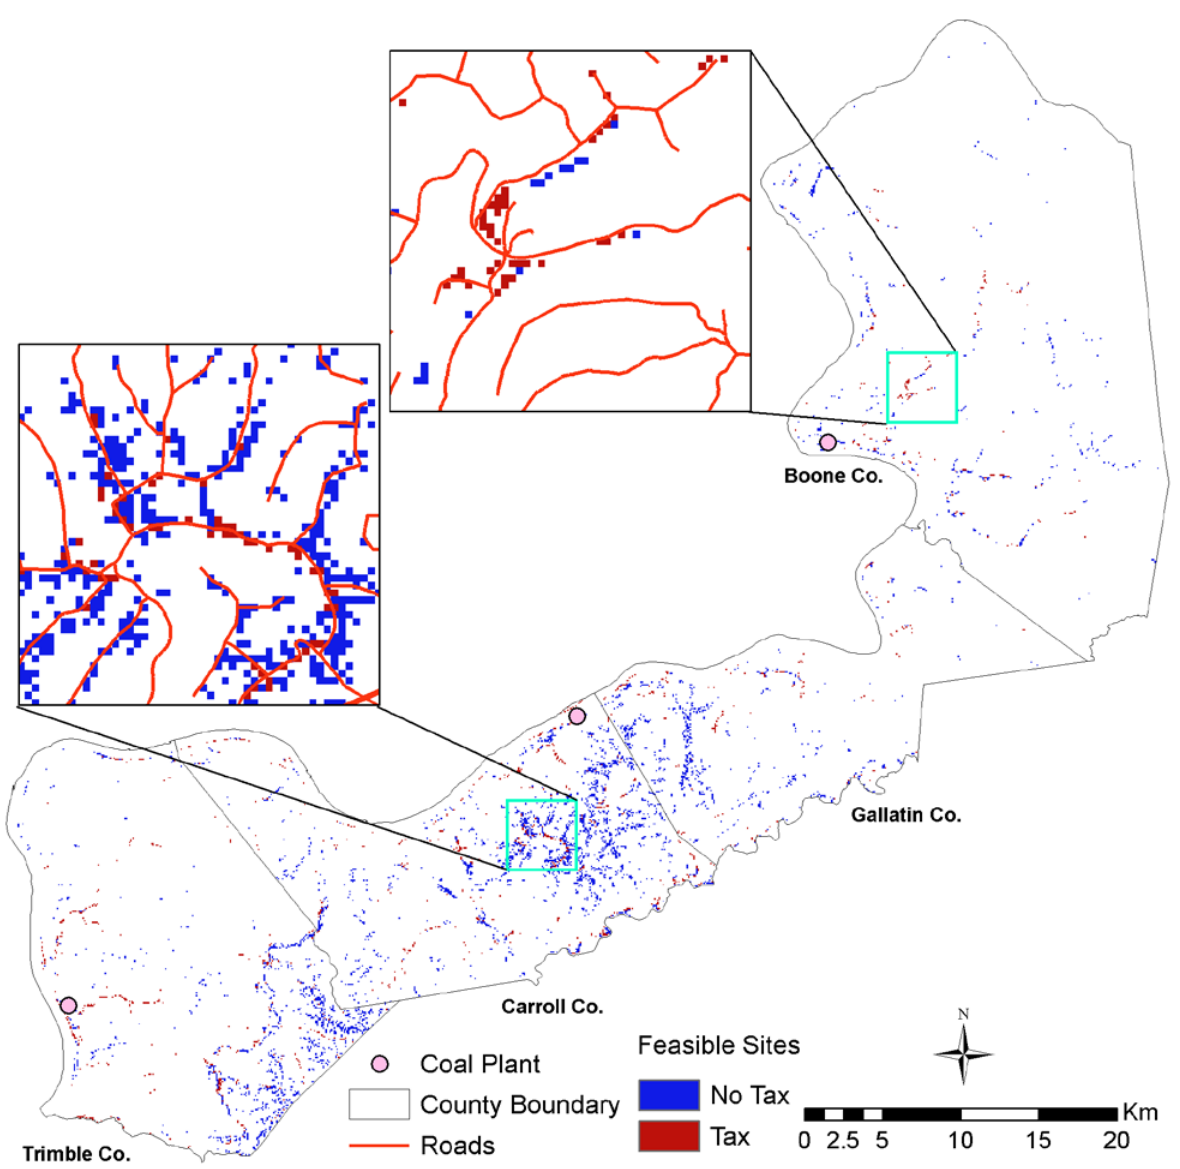
Figure 7. Spatial distribution of economically feasible sites for establishing sweetgum with and without property tax